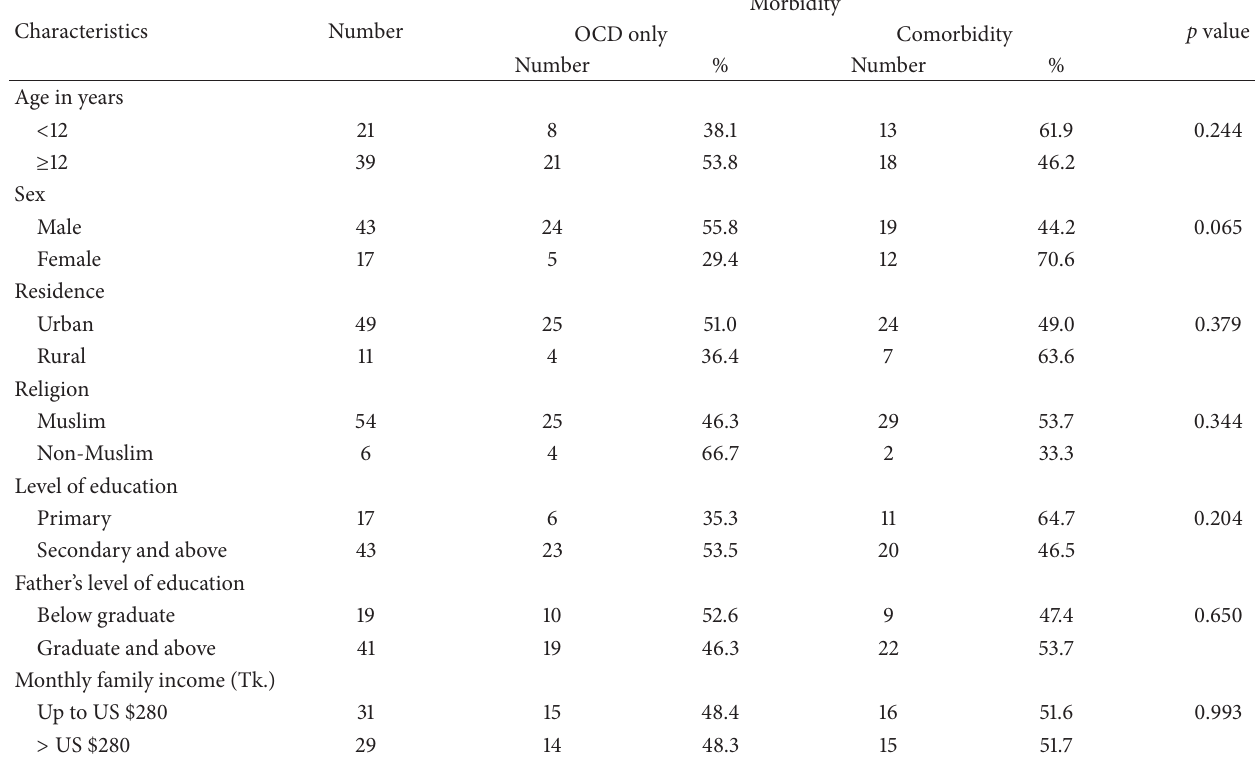
Table 4: Relationship between morbidity and selected sociodemographic